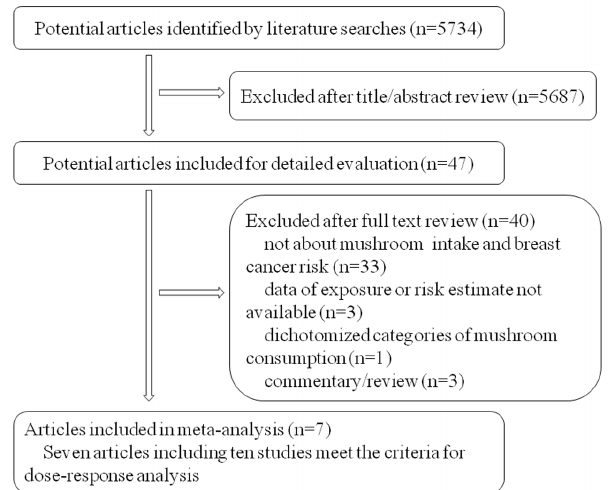
Figure 2. The dose-response analysis for the association of mushroom consumption and breast cancer risk, with restricted cubic splines in random-effects dose-response model. The solid line and the short dash line represent the estimated relative risks and corresponding 95% CIs, respectively.